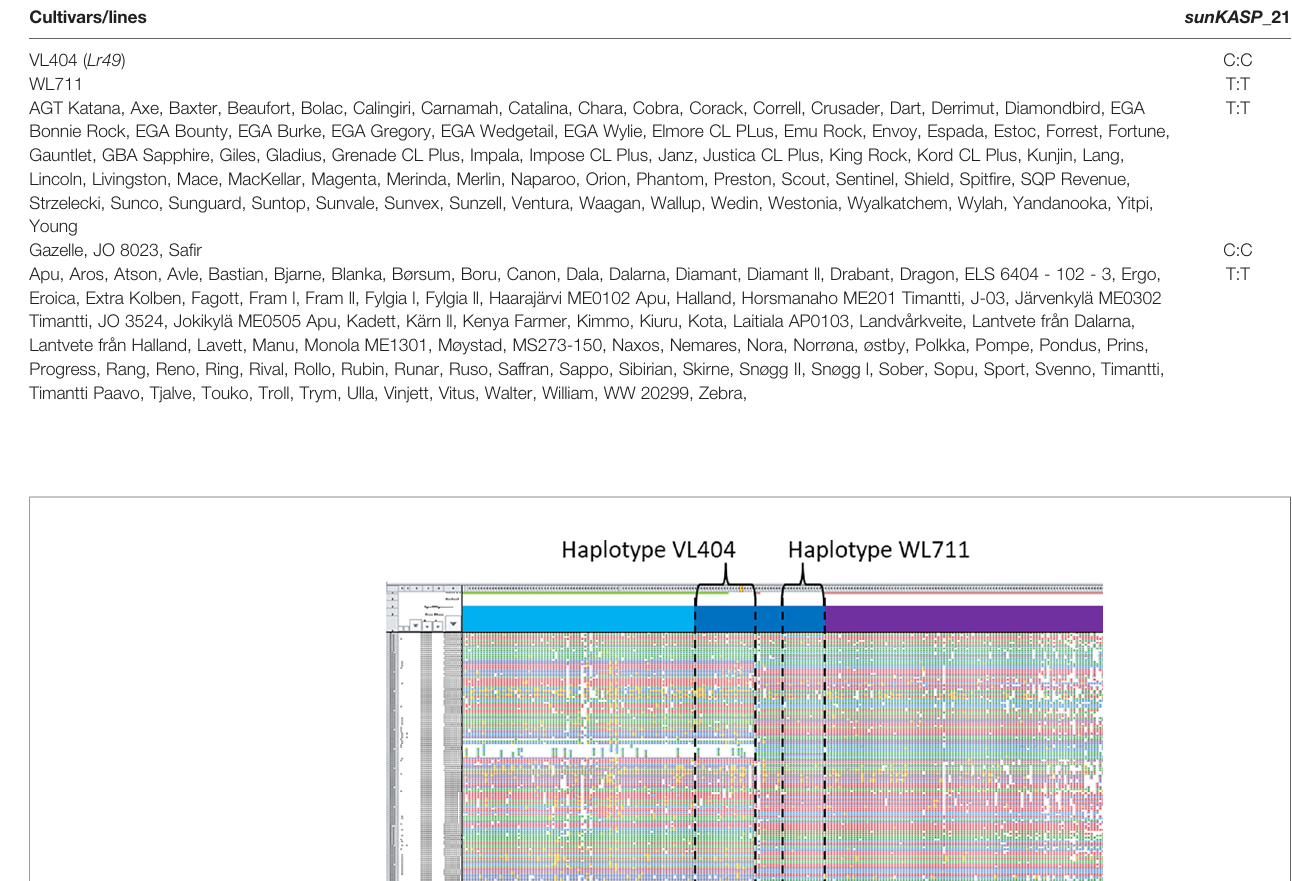
TABLE 2 | Validation of closely linked kompetitive allele-speci fi c PCR (KASP) marker on Australian and European wheat cultivars.